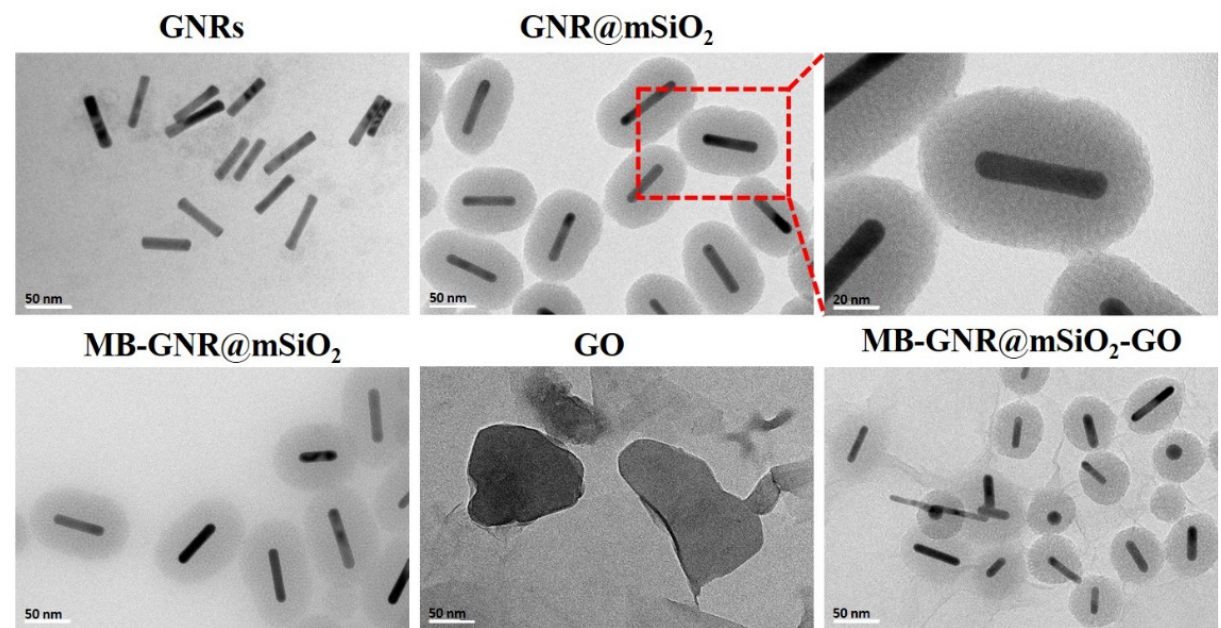
Figure 1. FETEM images of gold nanorods (GNRs), mesoporous silica-coated gold nanorods (GNR@mSiO 2 ), methylene blue-loaded mesoporous silica-coated gold nanorods (MB-GNR@mSiO 2 ), graphene oxide (GO), and methylene blue-loaded mesoporous silica-coated gold nanorods on gra- phene oxide (MB-GNR@mSiO 2 -GO).